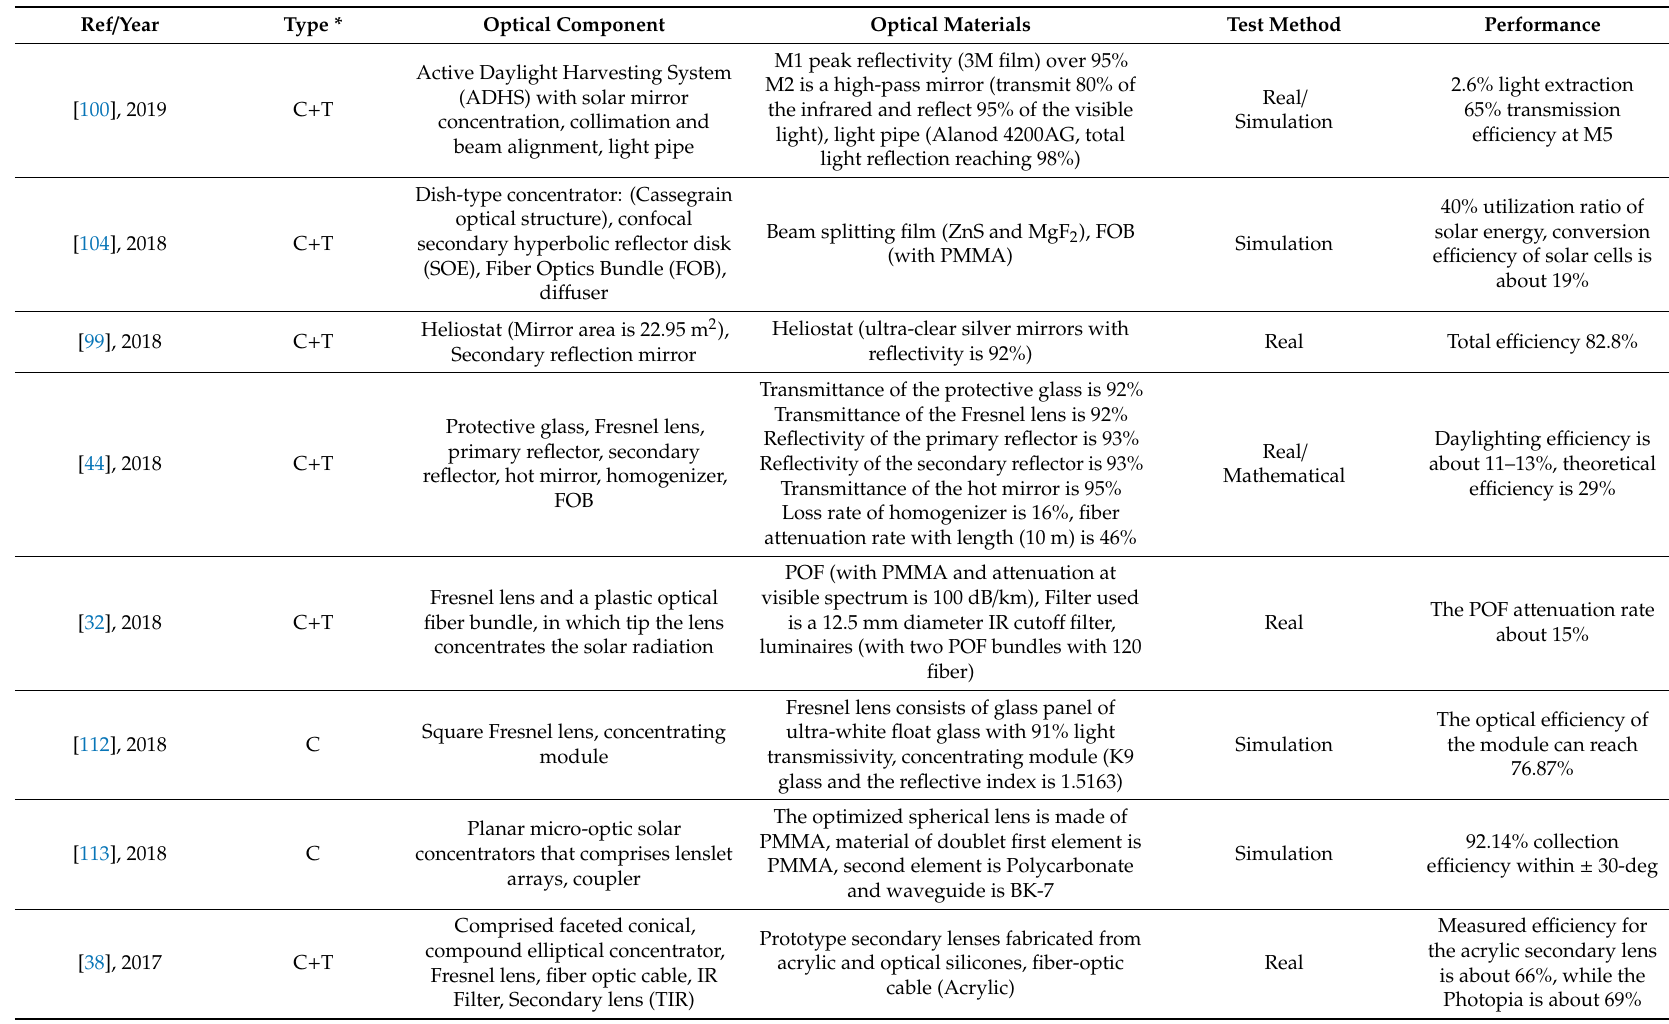
Table 8. Innovative optical design components, optical materials and